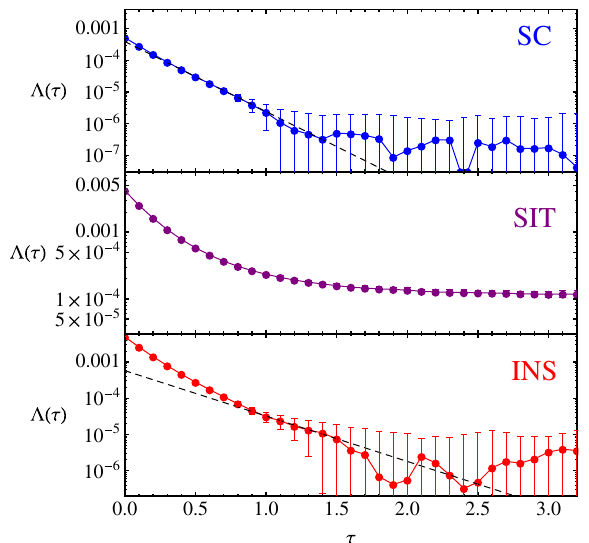
FIG. 7. Imaginary-time correlation functions Λ ð τ Þ for the clean transition in the superconducting phase ( E c =E J ¼ 3 . 22 ), the insulating phase ( E c =E J ¼ 4 . 76 ), and near the critical point ( E c =E J ¼ 4 . 17 ). Dashed lines indicate the gap scales that can be reliably extracted in the SC and insulating